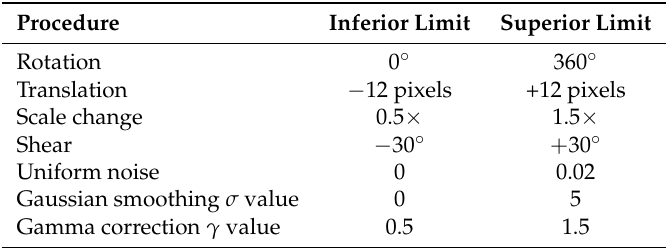
Table 2. Uniform distributions limits used in the image augmentation